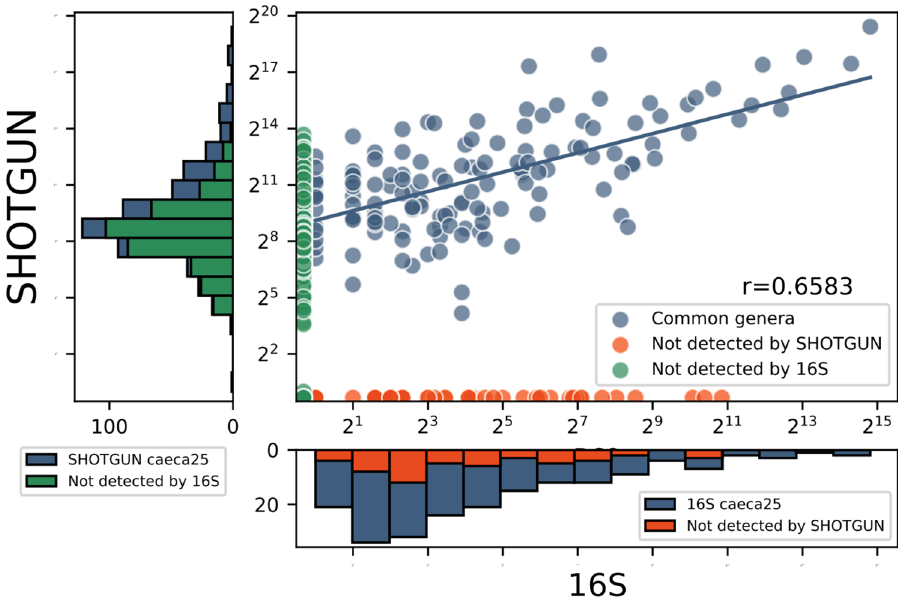
Figure 4. Scatter plot of 16S and shotgun genera abundances of one sample selected as example (caeca25). Histograms display stacked bars, where every column is divided in a part corresponding to the abundance of genera detected by both sequencing strategies (blue) and the other part is relative to genera detected exclusively by only one strategy (red for 16S and green for shotgun). Pearson’s correlation coefficient is computed only for the common genera. Logarithmic (log 2 ) scale helps to recognize that less abundant genera identified by shotgun sequencing are almost not detected by 16S sequencing.